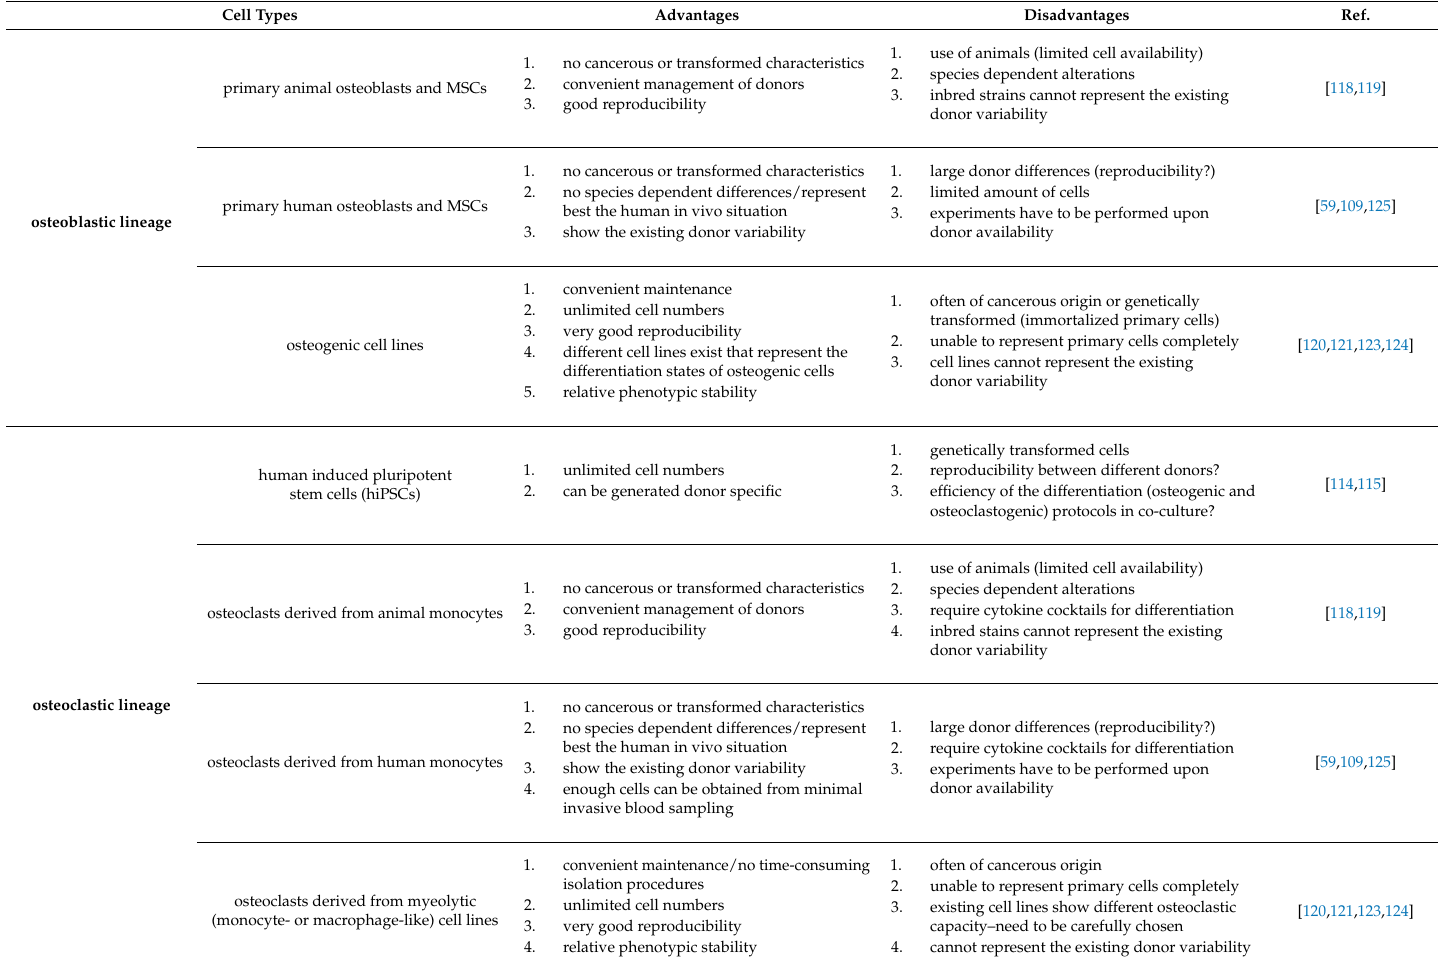
Table 3. Cell types used in co-cultures for bone